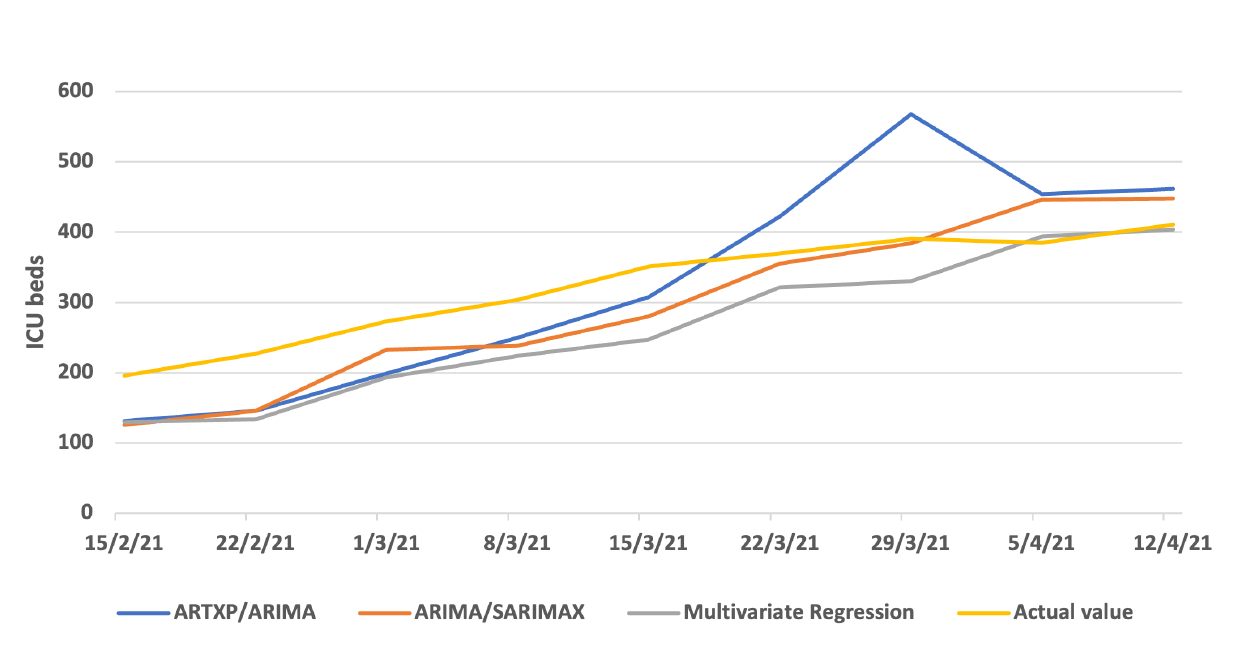
Figure A12. Three weeks Predicted vs. Actual